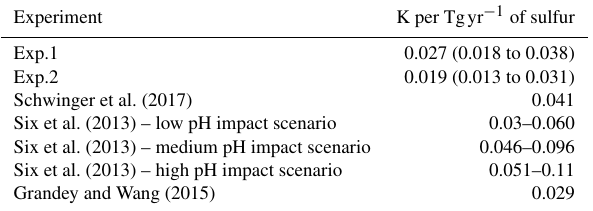
Table 4. The estimated temperature response to perturbations in the flux DMS (K per Tgyr − 1 of sulfur) for the current study’s ex- periments (Exp.1 and Exp.2) and those found in the literature. The ranges shown for Exp.1 and Exp.2 indicate the 10th and 90th per- centile confidence